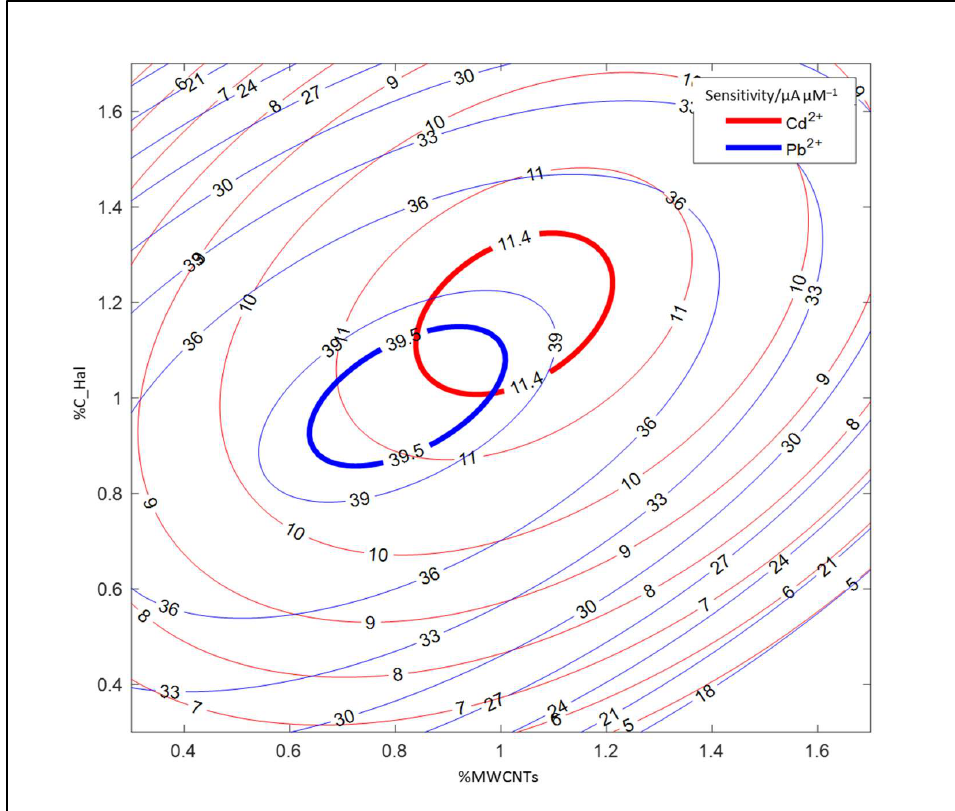
Figure 2. Projection of the model response surfaces for cadmium and lead determination.